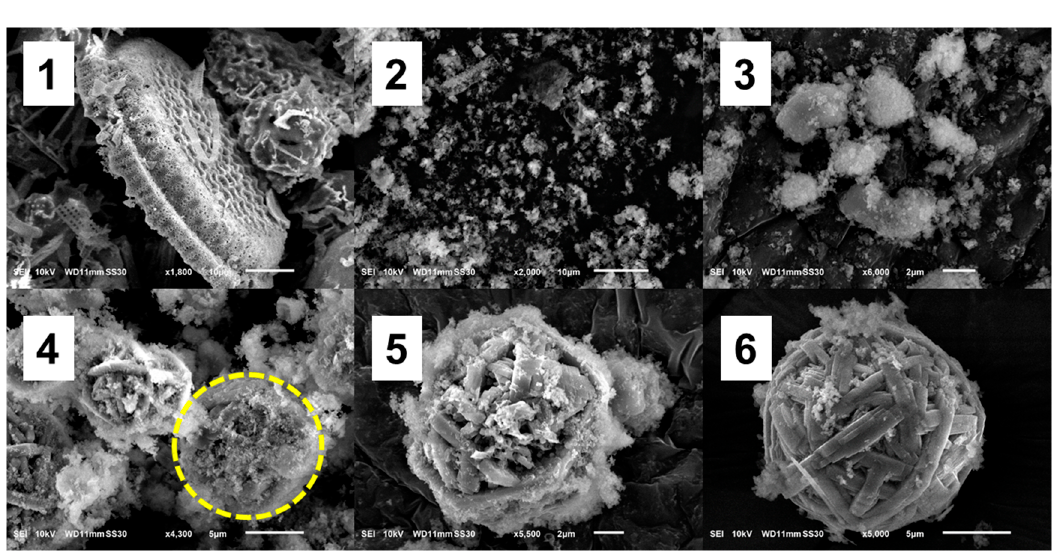
Figure 5. Formation of WBL microspheres from raw DE ( 1 ), mesophase ( 2 ), mesophase cluster ( 3 ), beginning of crystallization ( 4 ), fiber formation ( 5 ), and the WBL microsphere ( 6 ). The yellow circle shows a microsphere with a crystalline interior and a mesophase at the boundary.